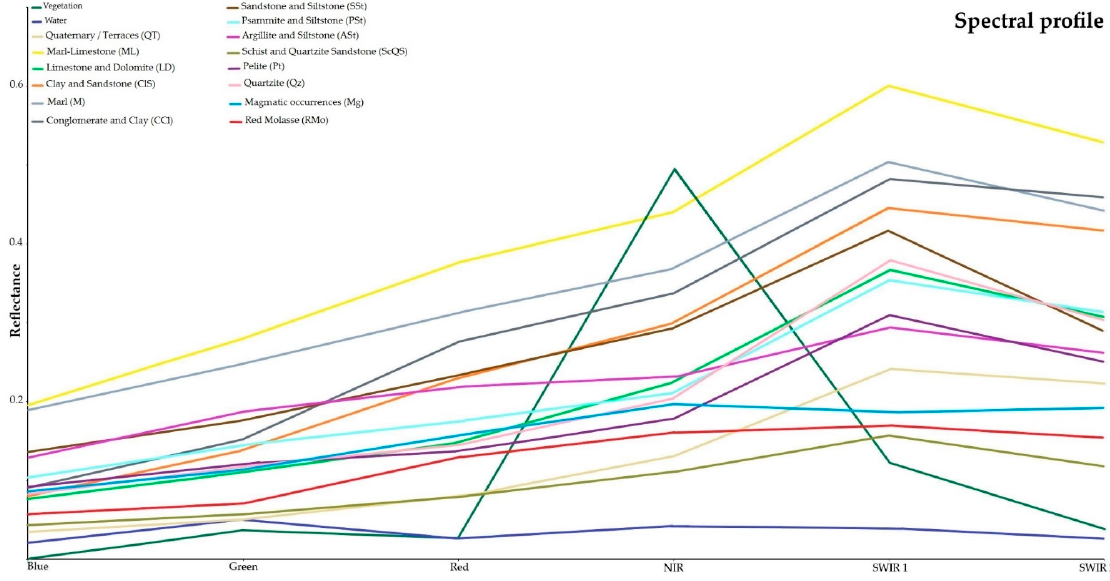
Figure 5. Average reflectance spectra of representative bedrock outcrops based on training samples selected from Sentinel 2A.